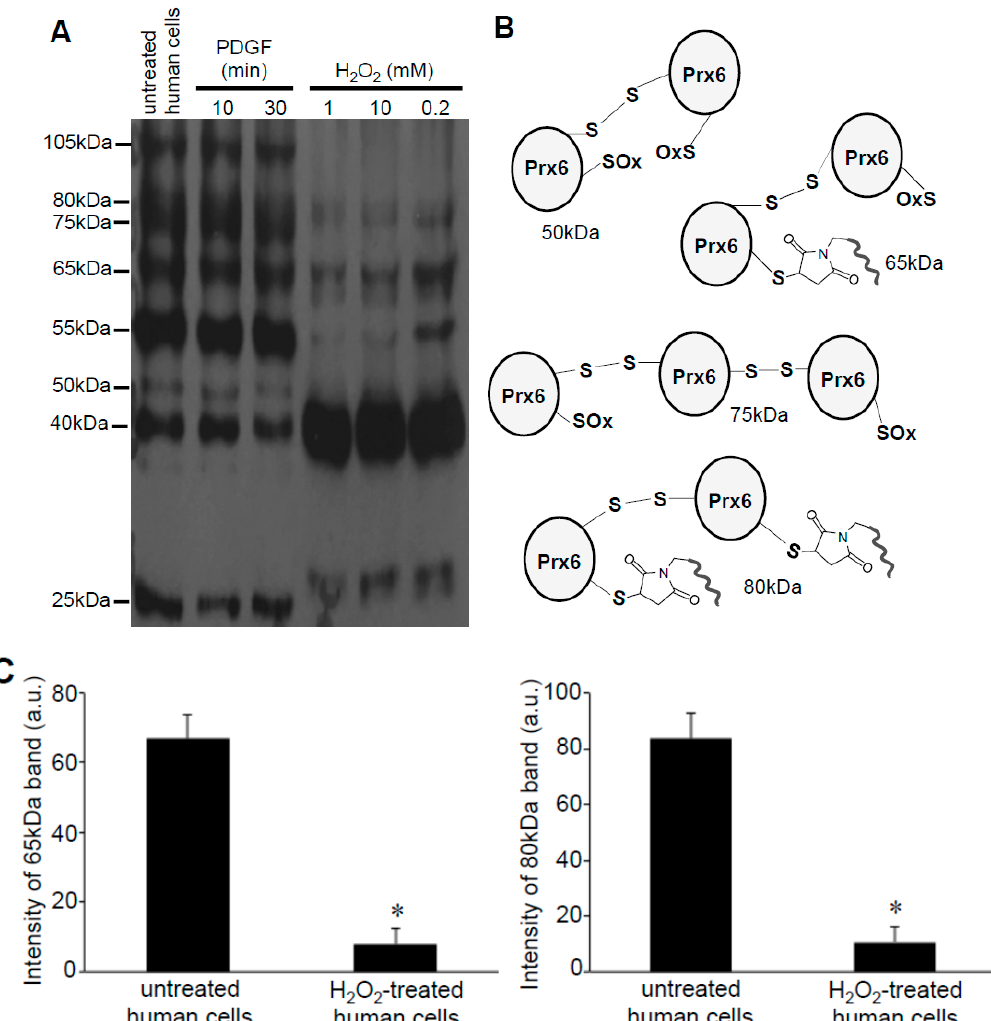
Figure 5. Identification of Prx6 multimers in human cells. ( A ) Human pulmonary artery smooth muscle cells were treated with or without PDGF (10 ng/mL) or H 2 O 2 at indicated concentrations for 15 min. Cell lysates were prepared, incubated with Protein-SHifter Plus, subjected to SDS-PAGE without BME, and immunoblotted with the Prx6 antibody. ( B ) Possible structures of Prx6 that produce bands of various molecular weights. ( C ) Bar graphs represent the means ± SEM of the intensities of 65- and 80-kDa bands ( n = 4). The symbol * represents the value significantly different from the untreated control value at p < 0.05.